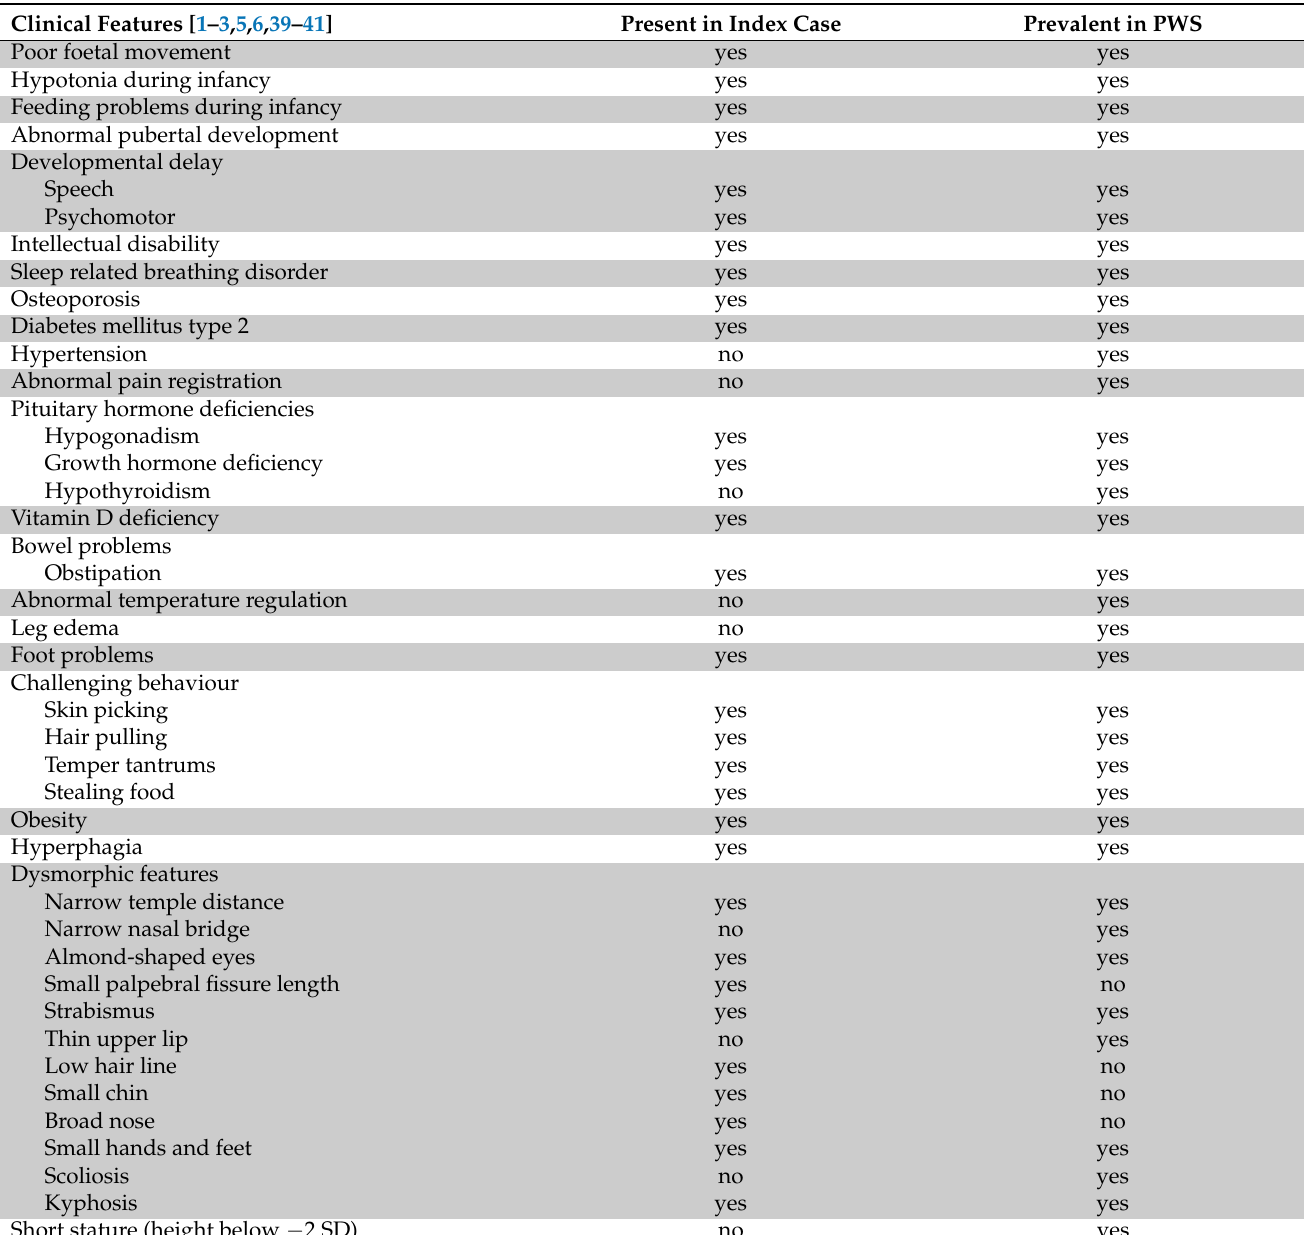
Table 2. Clinical features, dysmorphic features, and challenging behavior associated with PWS and presence in the index case. Clinical Features [1–3,5,6,39–41]